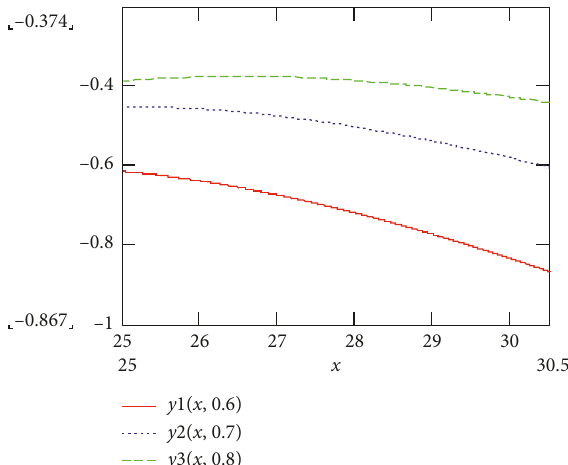
Figure 5: Main retracement channel deflection curve.